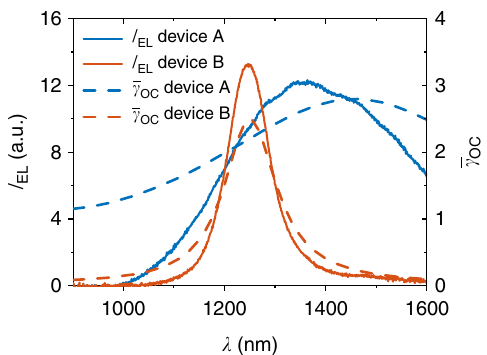
Fig. 2 EL spectra and out-coupling factor of an OSC with and without semitransparent layer. EL spectra of a P3HT:PC 61 BM cell without (type A, see Fig. 1) and with a thin, semitransparent Ag layer on top (type